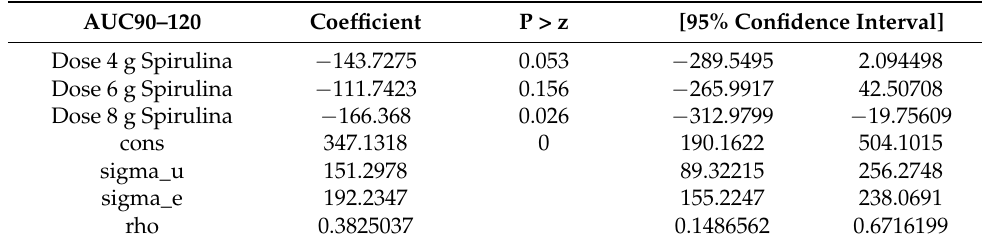
Table 7. Multi-level random effects regression model for area under the curve for blood glucose concentrations from 90 to 120 min